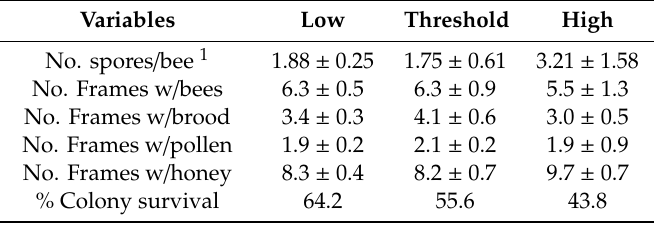
Table 4. Populations, food store parameters (mean ± SE), and percent survival of honey bee colonies categorized by the intensity of Nosema ceranae infections (low, threshold, high) in the summer, that were alive the following spring ( n =